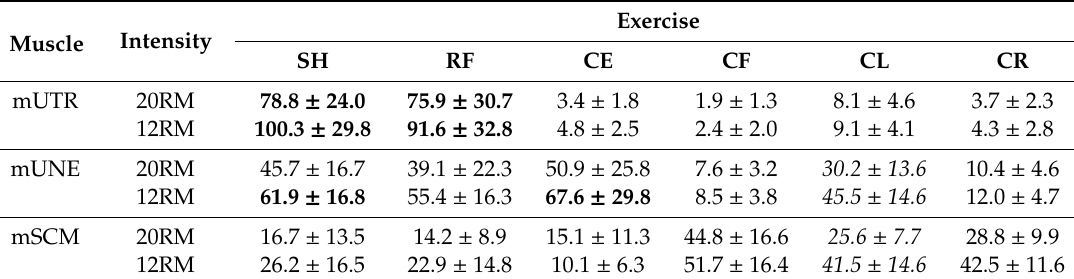
Table 1. Mean muscle activity (%MVE) for representative muscle groups shown for each exercise at 12RM and 20RM intensities. Values are presented as mean ± SD. Values > 60% MVE are marked in bold. Italic values are unilateral data, see